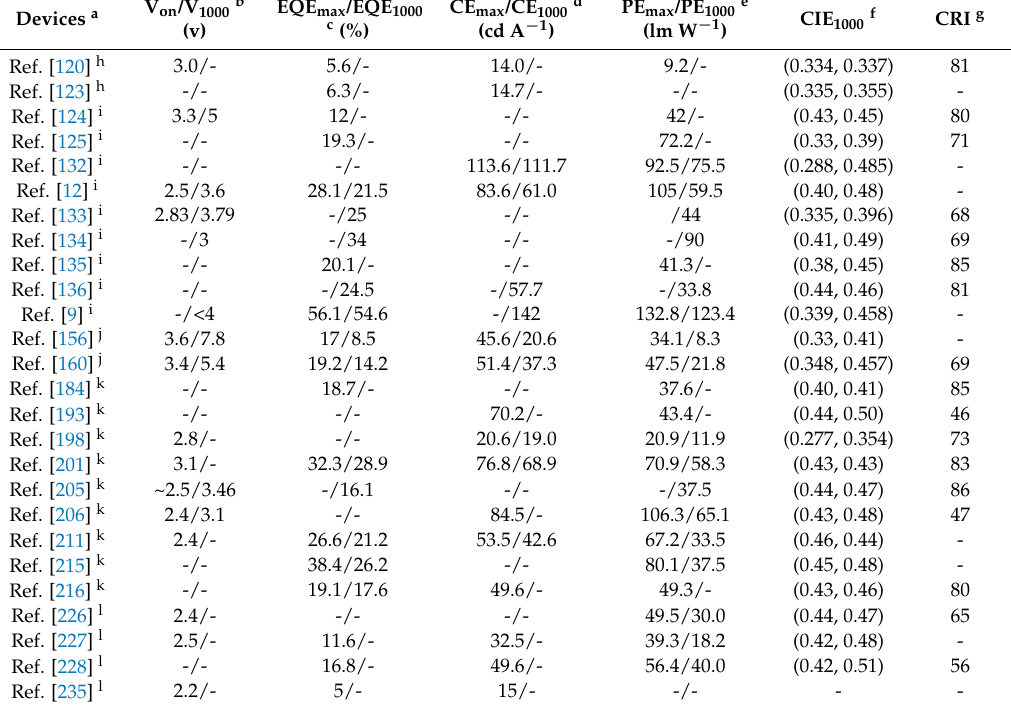
Table 1. Summary of the performances of WOLEDs with representative device